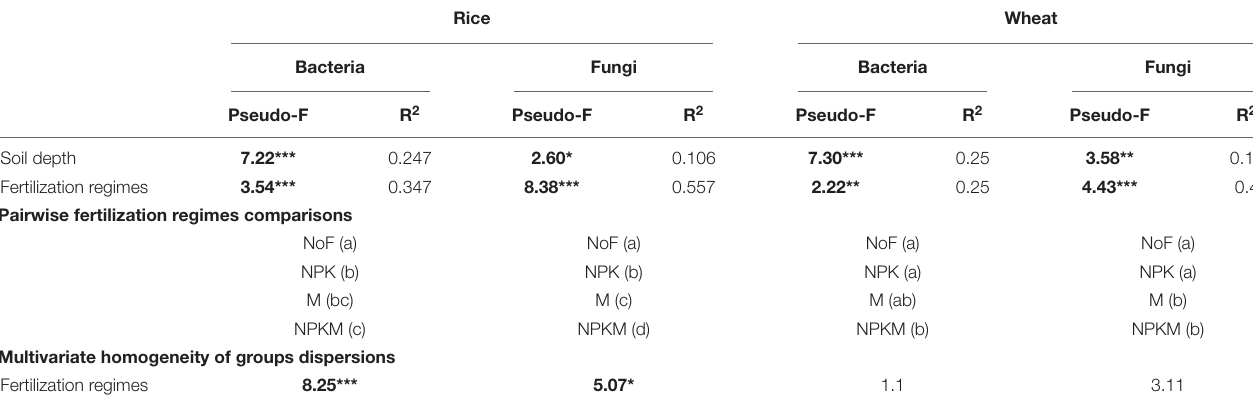
TABLE 3 | Results of PERMANOVA and BETADISP testing for differences in multivariate dispersion between fertilization regimes, crop rotation, and soil depth in bacterial and fungal